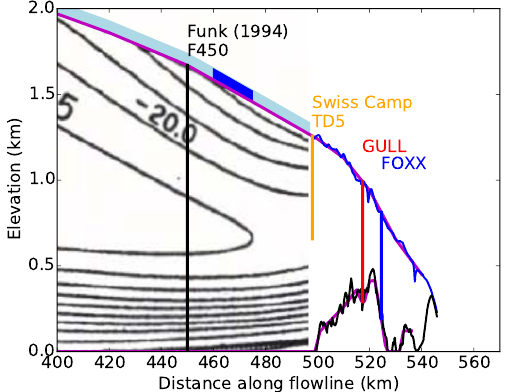
Figure 3. The locations and depths of temperature profiles at sites TD5, GULL and FOXX are shown as colored vertical lines on a background plot of the modeled temperature field from Fig. 7b in Funk et al. (1994). The temperature profile F450 at horizontal coor- dinate 450km is used as model input. Bedrock (black) and surface (blue) was obtained from radar data (Gogineni, 2012). Smoothed versions, indicated with purple lines, were used as model input. The light blue area indicates cold firn conditions, and the dark blue area between 460 and 475km the area within which the temperate firn that emerges at TD5 was accumulated between 1570 and